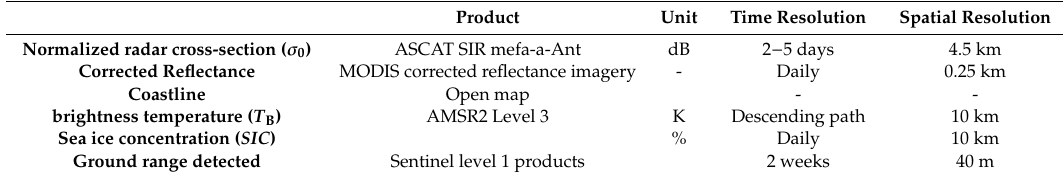
Table 1. Summary of the satellite data products. ASCAT: Advanced scatteromter; SIR: Scatterometer image reconstruction; MODIS: Moderate Resolution Imaging Spectroradiometer.